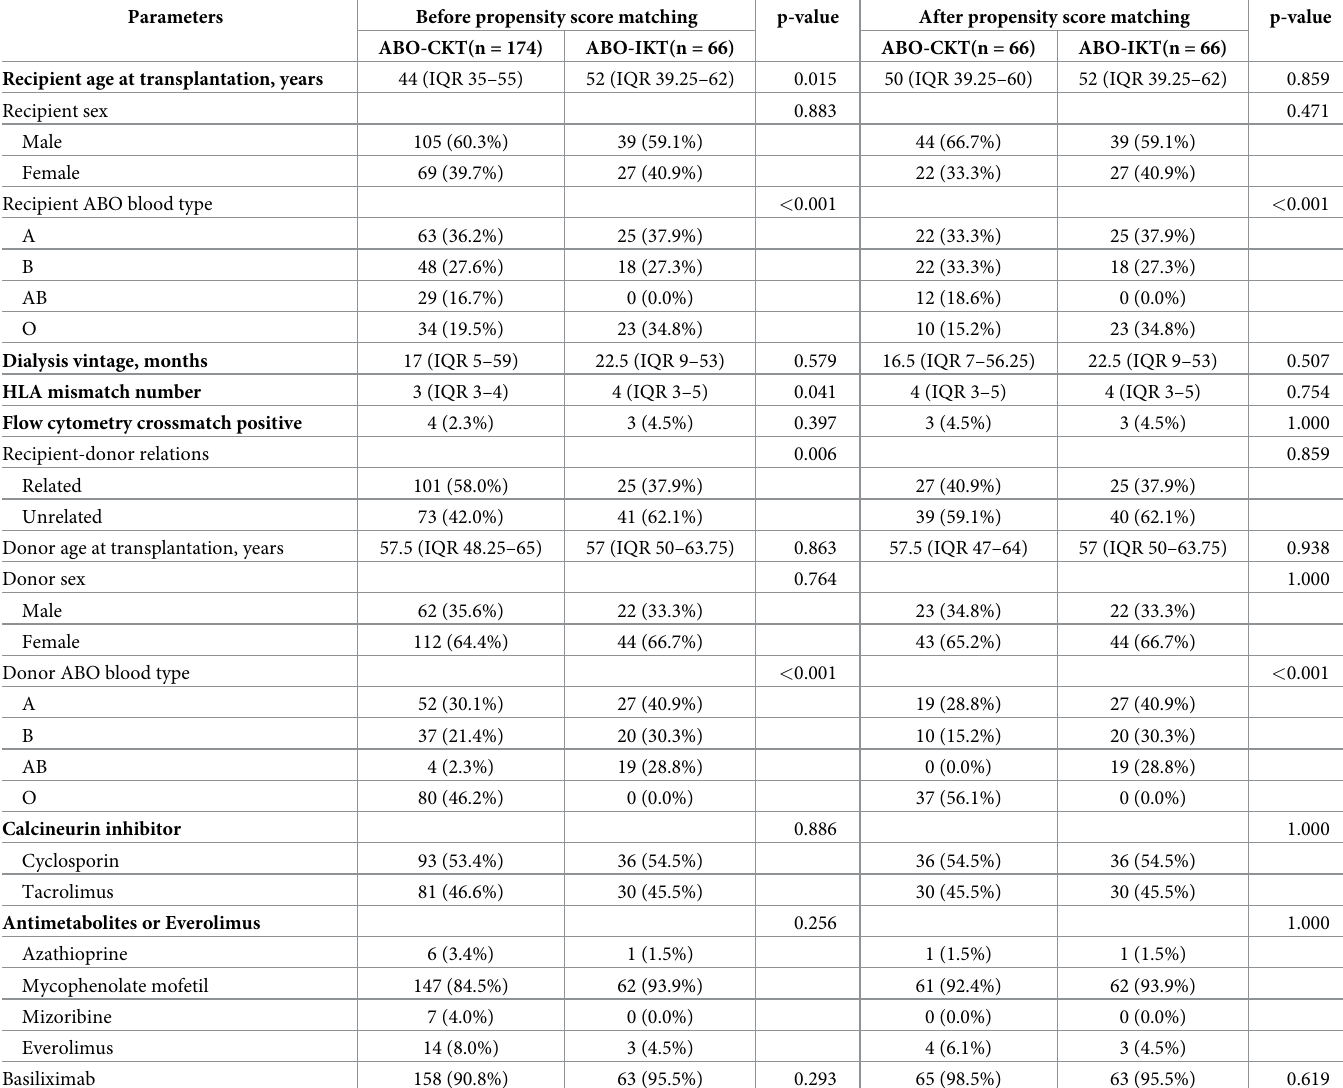
Table 1. Patient characteristics before and after propensity score